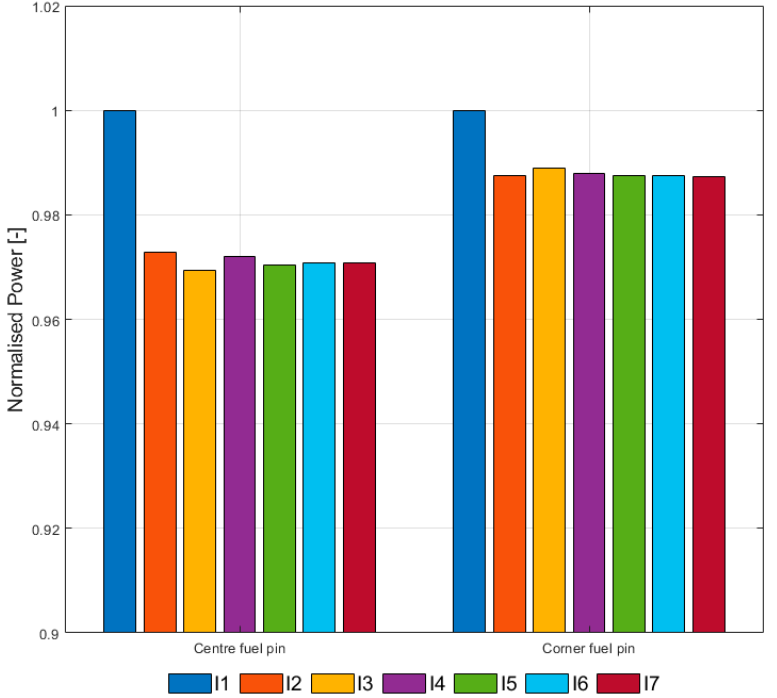
Figure 15. Pin powers for each iteration (I) for the centre and corner fuel pins of the assembly. Pin power is normalised by the maximum power of the pin.